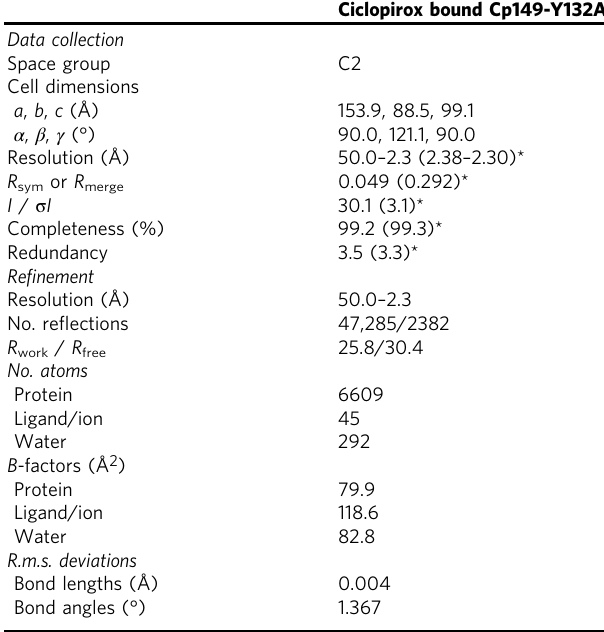
Table 1 Data collection and re fi nement